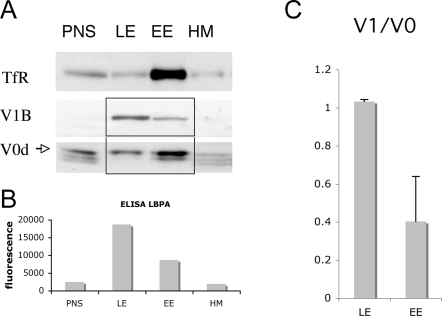
Increased assembly of the two sectors of the V-ATPase in late endosome.Subcellular fractionation of postnuclear supernatants (PNS) was performed to separate early (EE) from late endosomes (LE) and heavy membranes (HM) A: 20 µg of protein from each fraction were separated in 12.5% SDS-PAGE and blotted for the presence of TfR (early endosomal marker), V0d and V1B. B: The late endosomal lipid LBPA was used to follow the distribution of late endosomes on the gradient. An equal amount of protein was used for LBPA detection by ELISA with the LBPA antibody (6C4). C: Western blot was quantified using a Phosphoimager (Bio-Rad Laboratories) and the ratio V1/V0 was plotted. Note that the ratio LE/EE is higher for the V1B subunit than for the V0d subunit suggesting a higher assembly of the V-ATPase in the late endosomes compared to early endosomes.